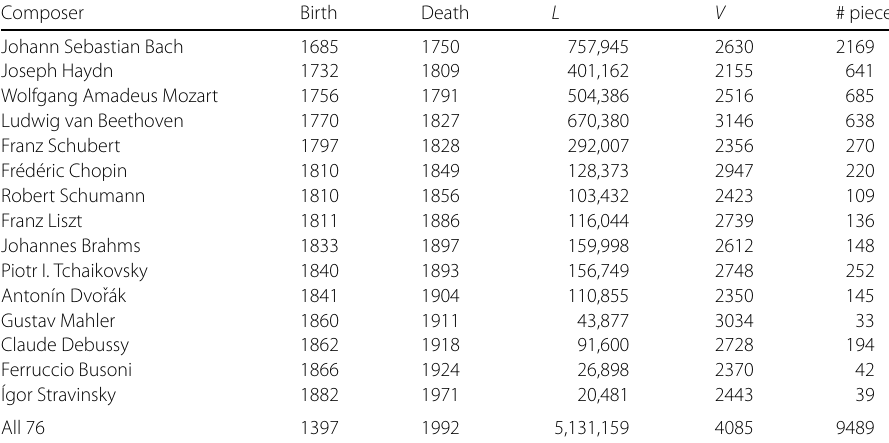
Table 2 Length L in number of tokens and size of vocabulary V for the 15 composers that are best represented in the Kunstderfuge corpus (after transposition). Year of birth, year of death, and number of pieces (# pieces) are also included Composer Birth Death L V # pieces Johann Sebastian Bach